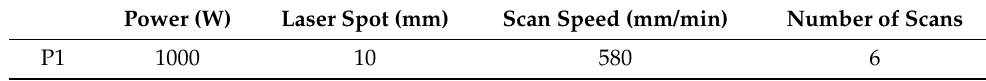
Table 2. Summary of the initial preheating parameters.